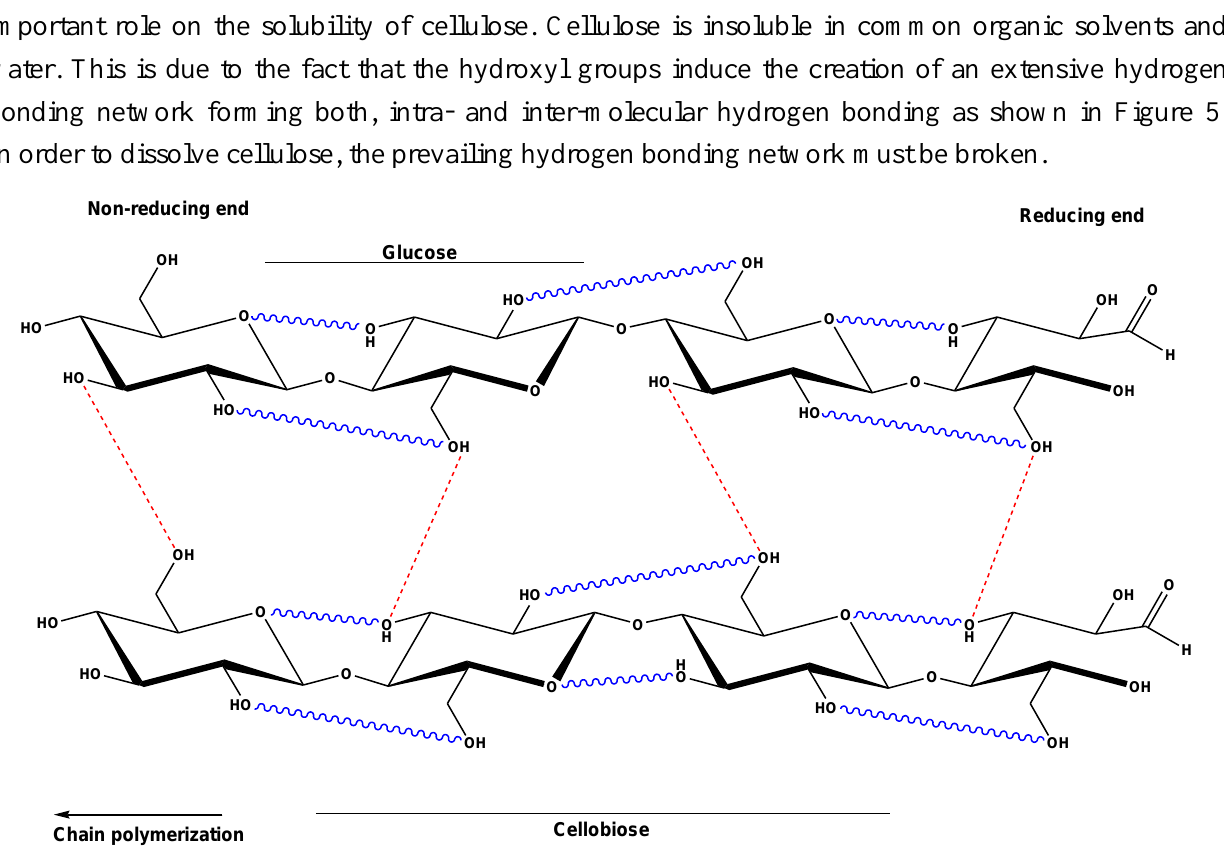
Figure 5. Structure of cellulose with inter- and intra-molecular hydrogen